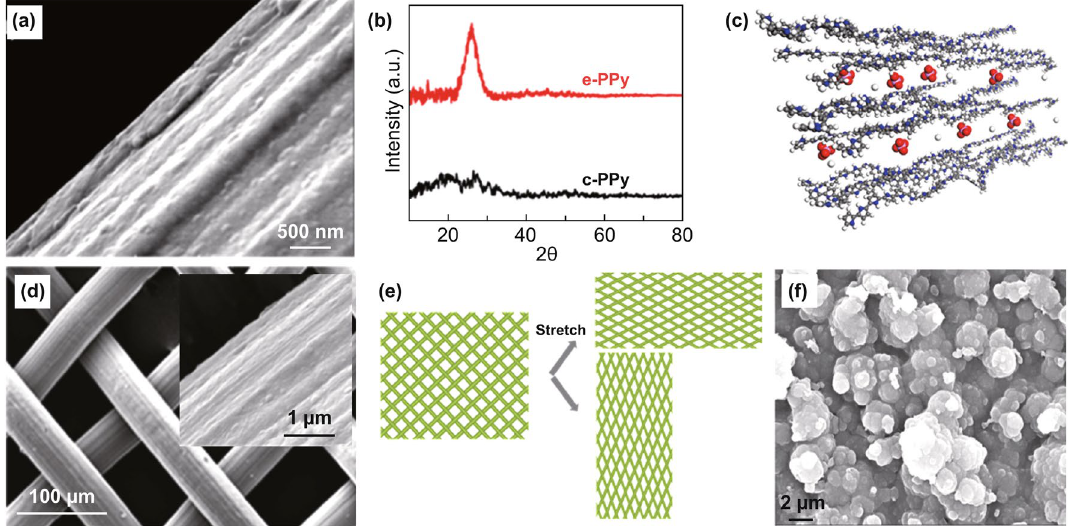
Fig. 11 a SEM image of electrodeposited PPy film on an oxygen‑functionalized carbon fiber. b XRD patterns of electrochemically and chemi‑ cally deposited PPy. c A possible molecular structure of electrodeposited PPy. d PPy film electrochemically deposited on a flexible stainless steel mesh. e Schematic illustration of the stretched mesh structure. f Cauliflower‑like PPy film. Adapted from a – c Ref. [143], d , e Ref. [132], f Ref. [105] with